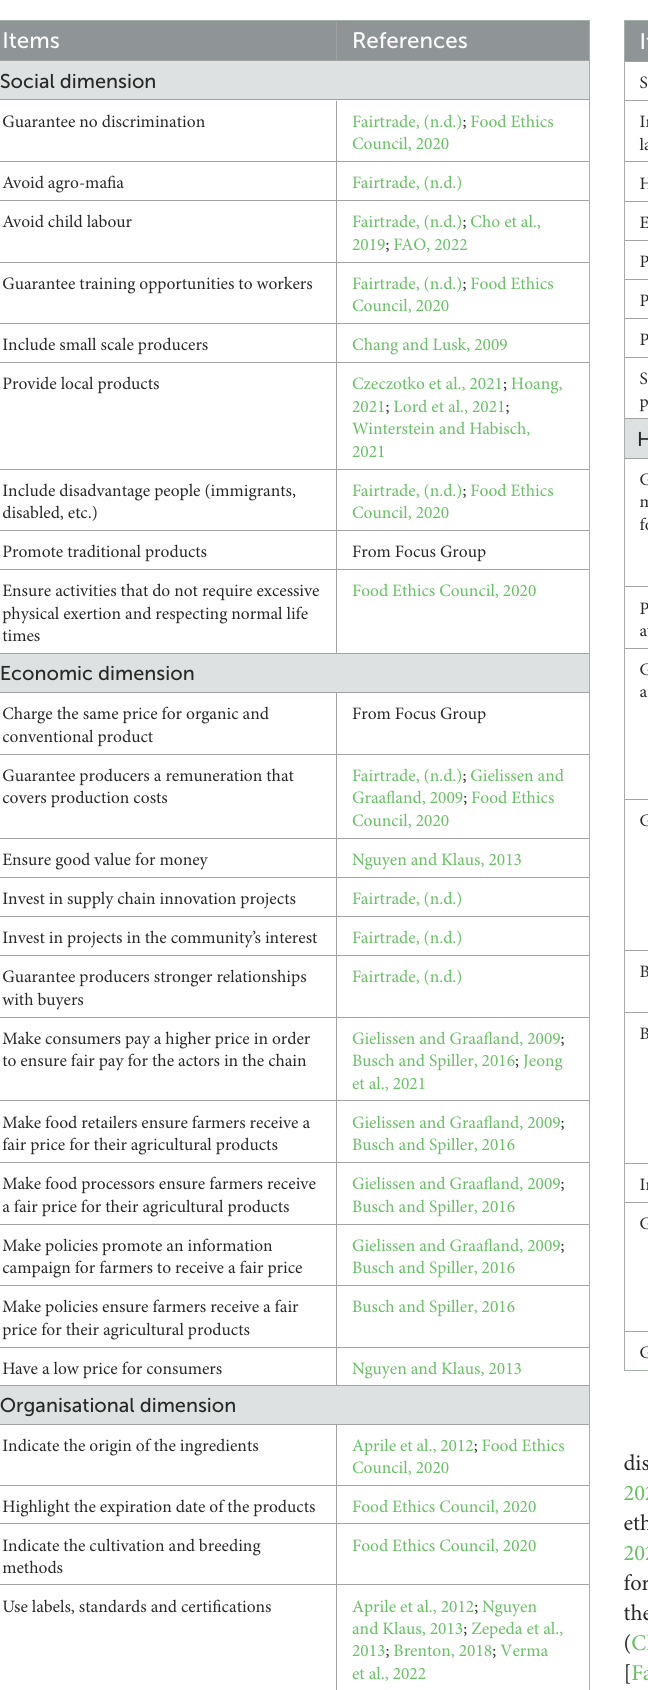
TABLE 1 Sources of questionnaire